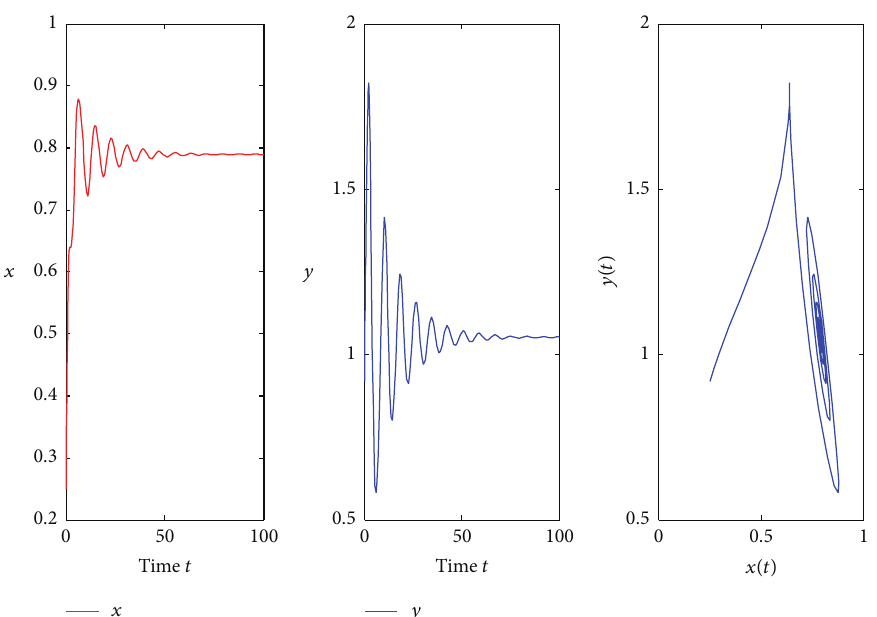
Figure 7: 𝐸 ∗ is asymptotically stable for 𝜏 1 = 0.15, 𝜏 2 = 1.65 < 𝜏 ∗ 20 = 1.8062 with initial values “0.25;0.92.”